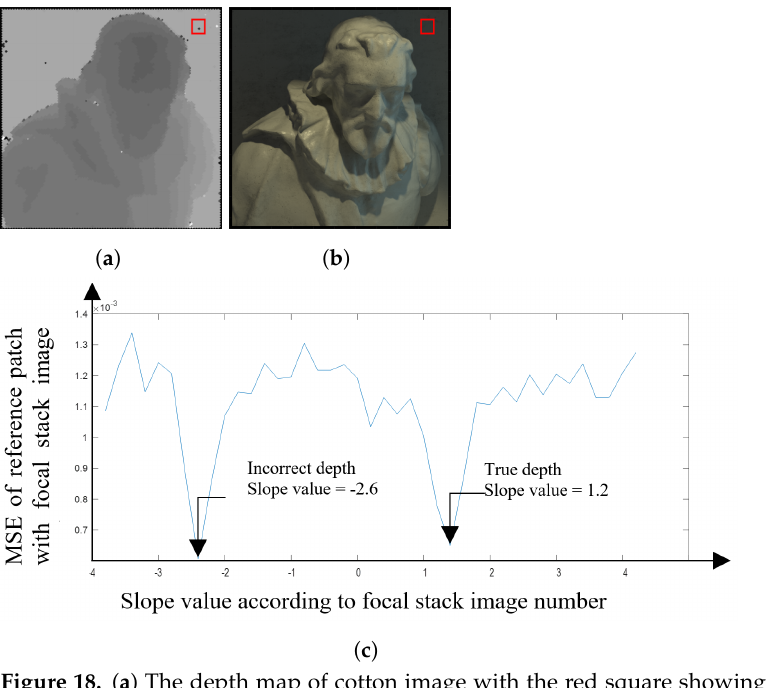
Figure 18. ( a ) The depth map of cotton image with the red square showing the cross error patch. ( b ) The central image with the red box showing the error patch. ( c ) The MSE of the central image patch with the patch at different focal